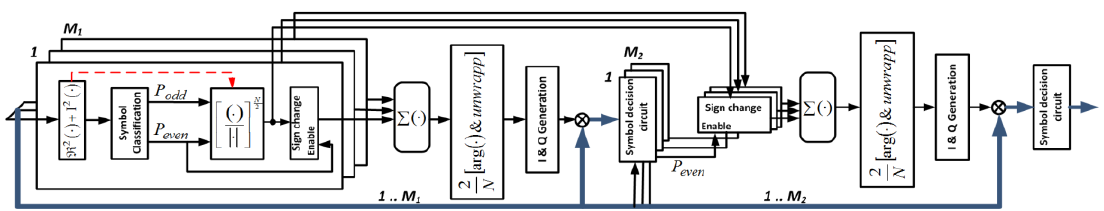
Figure 9. Flow chart of the proposed two-stage n-PSK partitioning CPR scheme for an optimization of its computational complexity. Table 1. Computational complexity of various CPR algorithms.